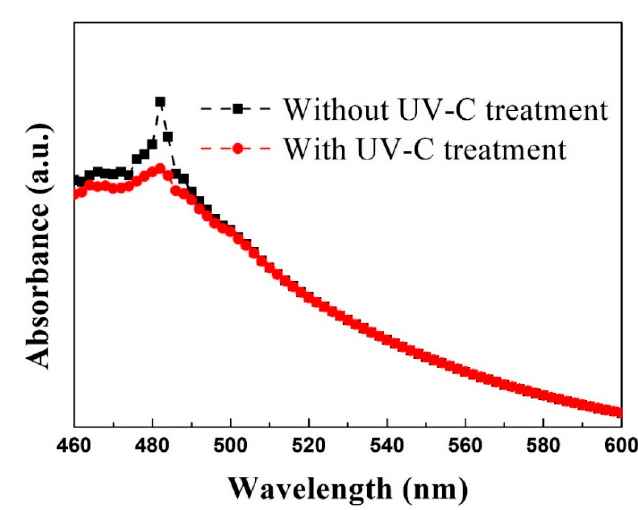
Figure 5. Absorbance of PbI 2 -coated m-TiO 2 / c-TiO 2 / FTO substrate with and without UV-C light surface treatment.